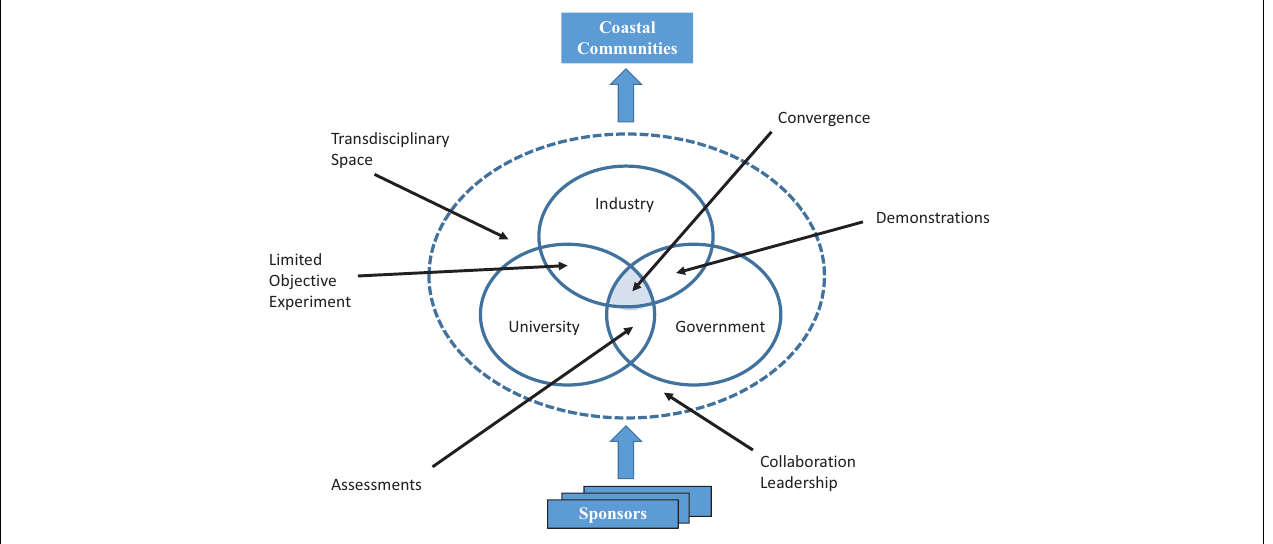
FIGURE 4 | Fully integrated projects should include stakeholders from government, academia, and industry. Collaboration leadership brings together the environmental scientists, engineers, and community to develop the theoretical foundations of coastal resilience through integrated research and training activities. Arrows indicate the flow of progress toward developing more resilient